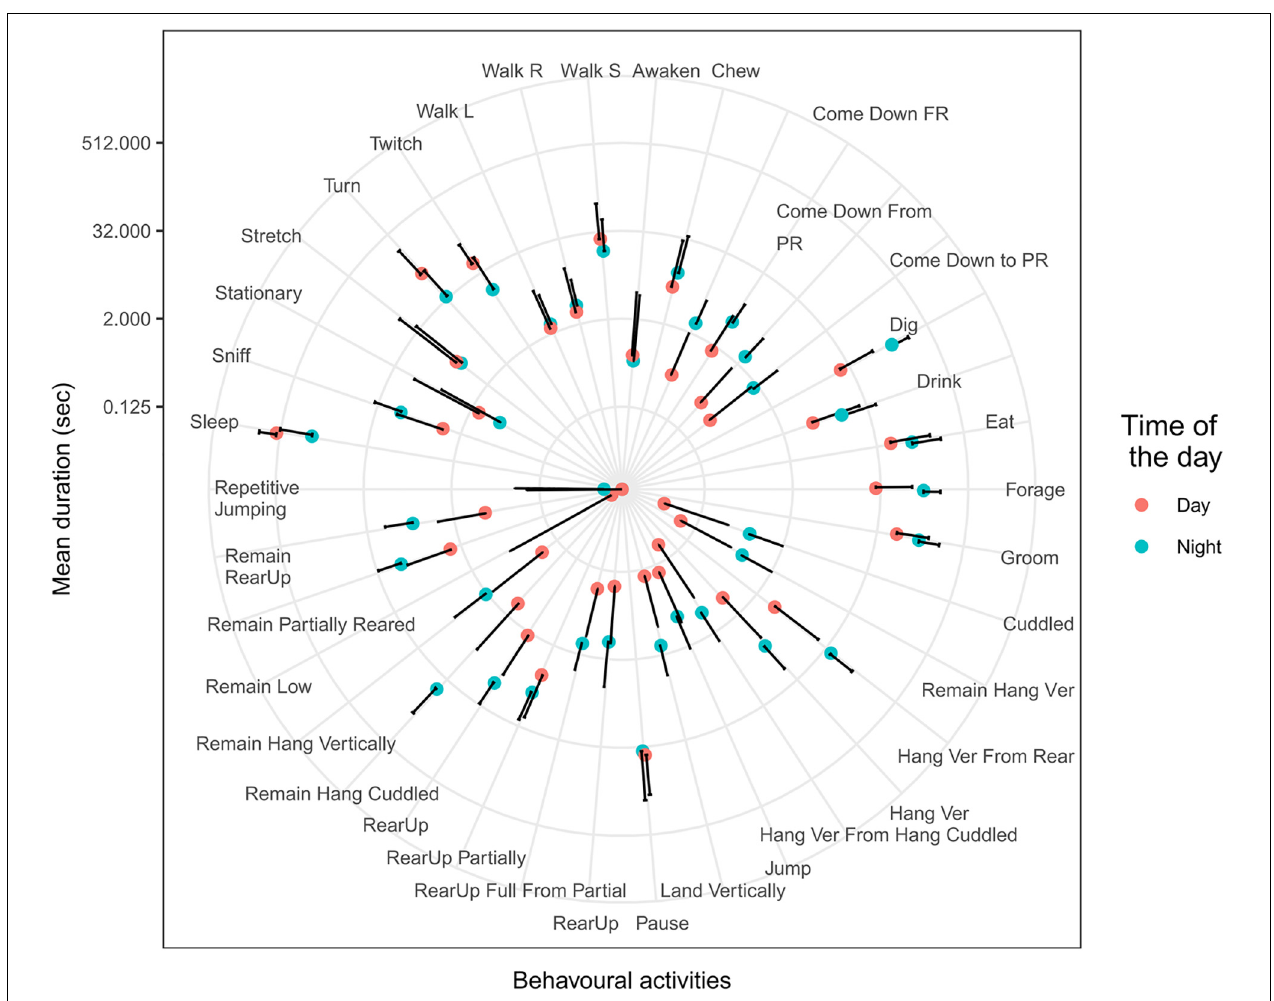
FIGURE 1 | Behavioral activities during day and night. Mean and SD of behavioral activities during 5-min windows during day (red dots) and night (blue dots). Durations of more than 20 activities were statistically different between day and night ( T -test, p < 0.001). Definition of behavioral activities described in Supplementary Table 1